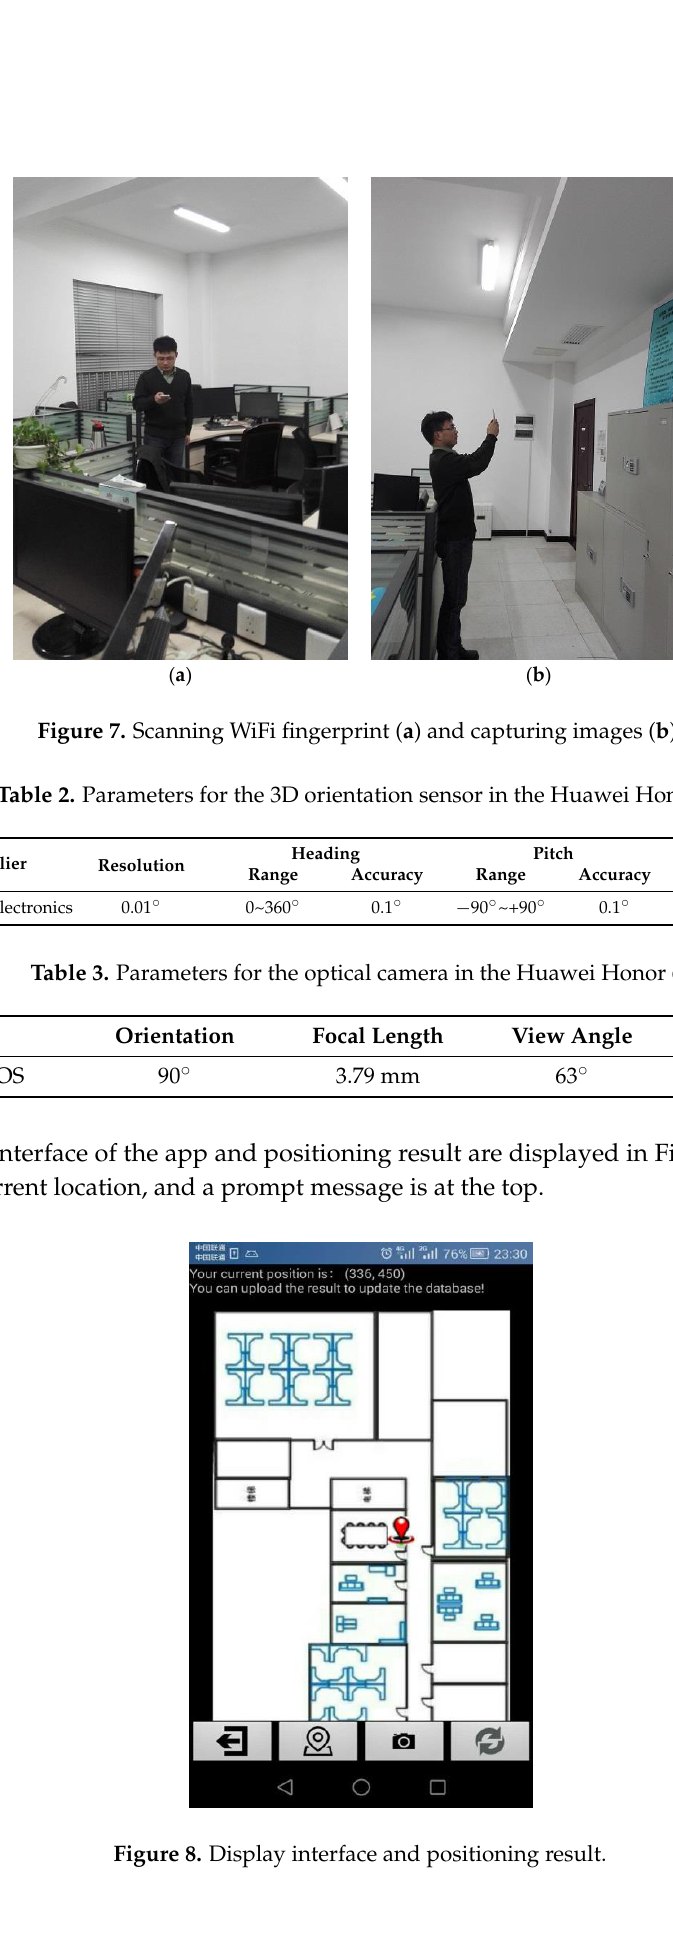
Figure 8. Display interface and positioning result.